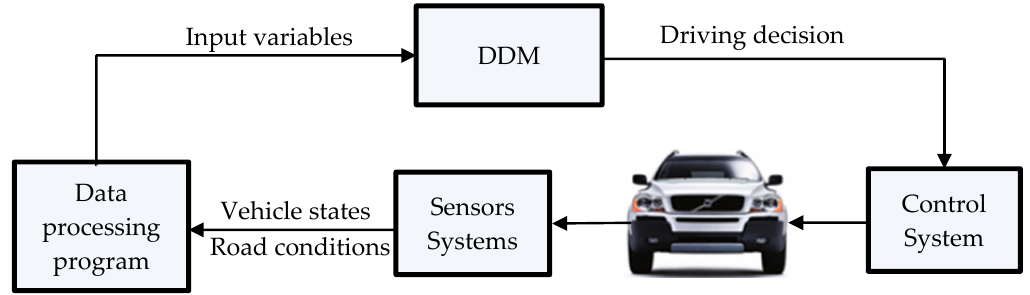
Figure 1. Schematic architecture of the driving decision-making process of autonomous vehicle. DDM: Driving Decision-making Mechanism.